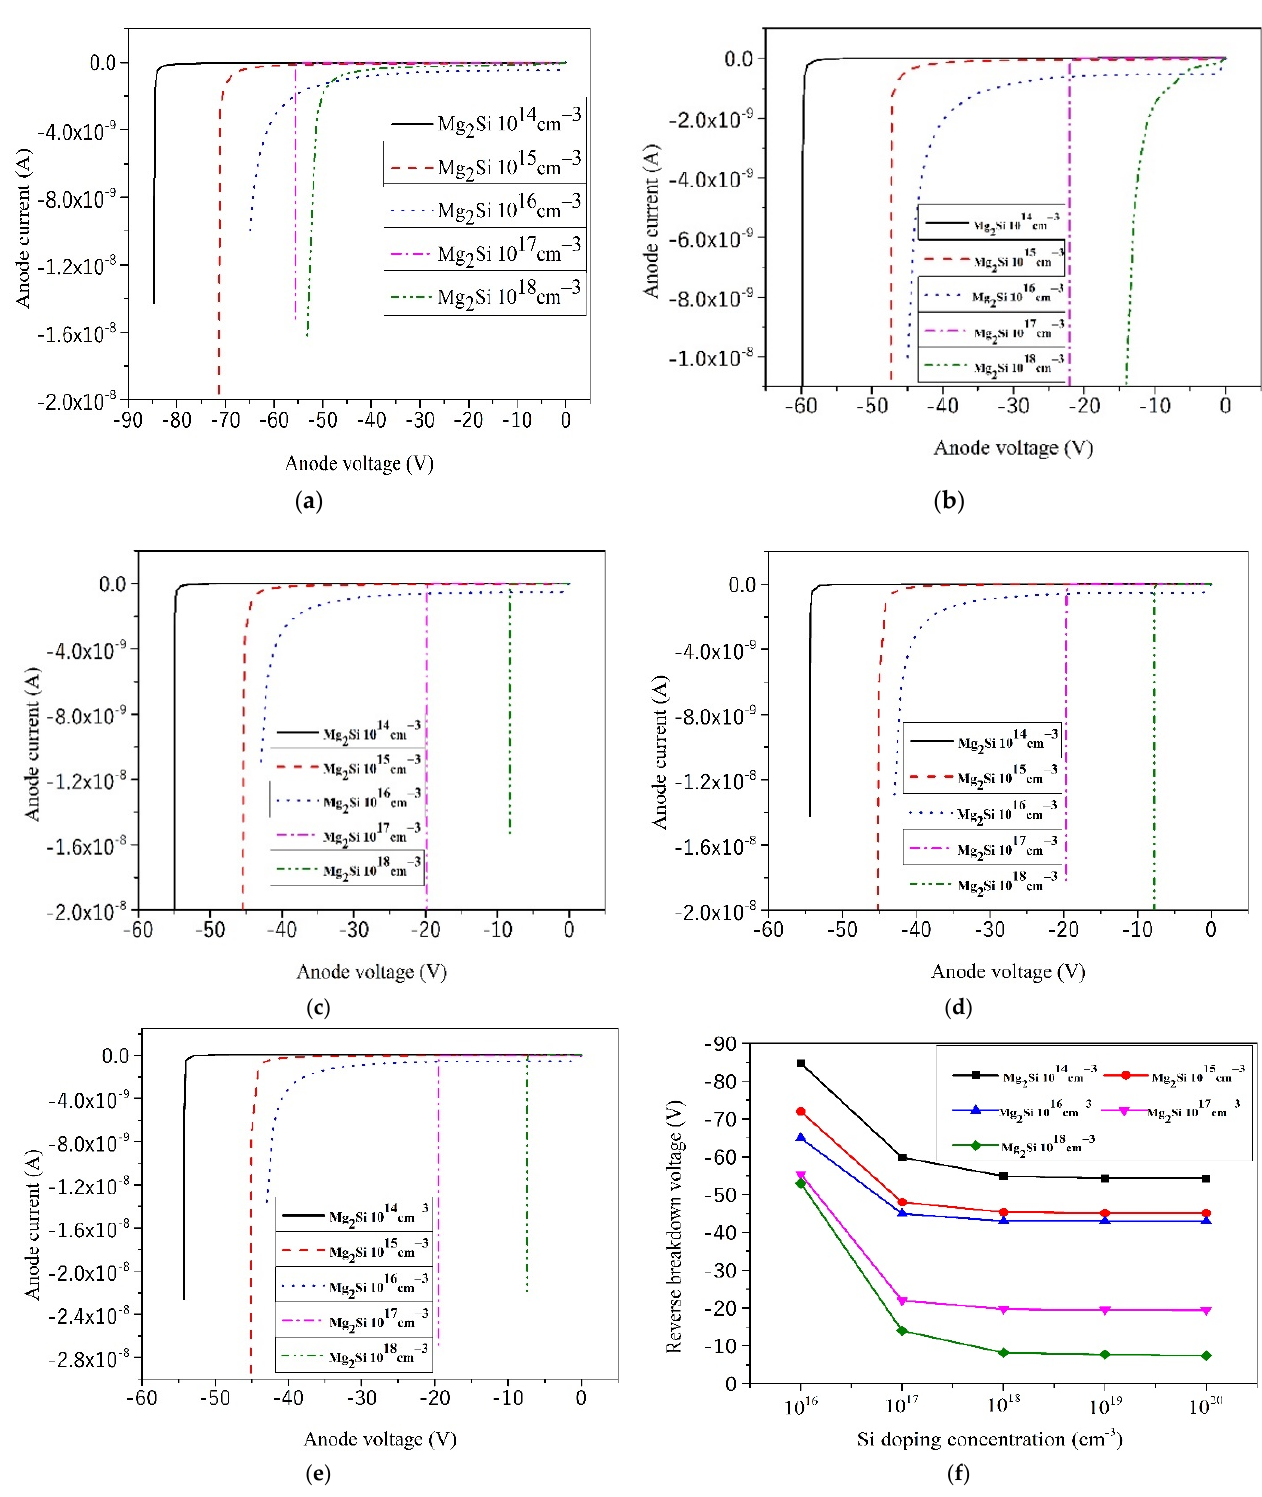
Figure 4. Reverse breakdown voltage curves of the heterojunction PDs with different doping concentrations. ( a ) Si–10 16 cm − 3 . ( b ) Si–10 17 cm − 3 . ( c ) Si–10 18 cm − 3 . ( d ) Si–10 19 cm − 3 . ( e ) Si–10 20 cm − 3 . ( f ) The effect of doping concentrations on reverse breakdown voltage.